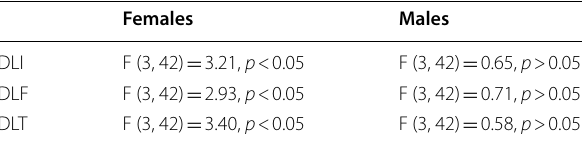
Table 2 Results of repeated measures ANOVA for DLI, DLF, and